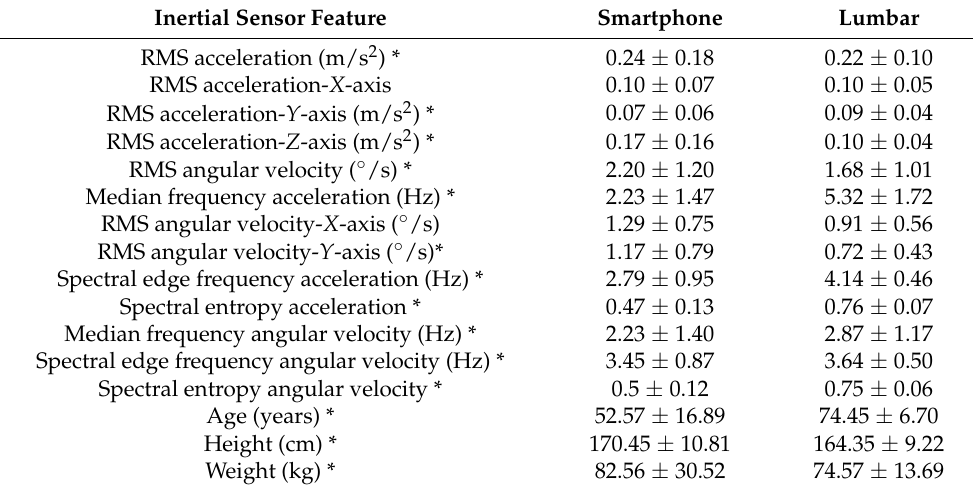
Table 1. Comparison of inertial sensors features obtained from a smartphone held against the torso to a statistically independent test set obtained from a lumbar mounted inertial sensor (reference data set).